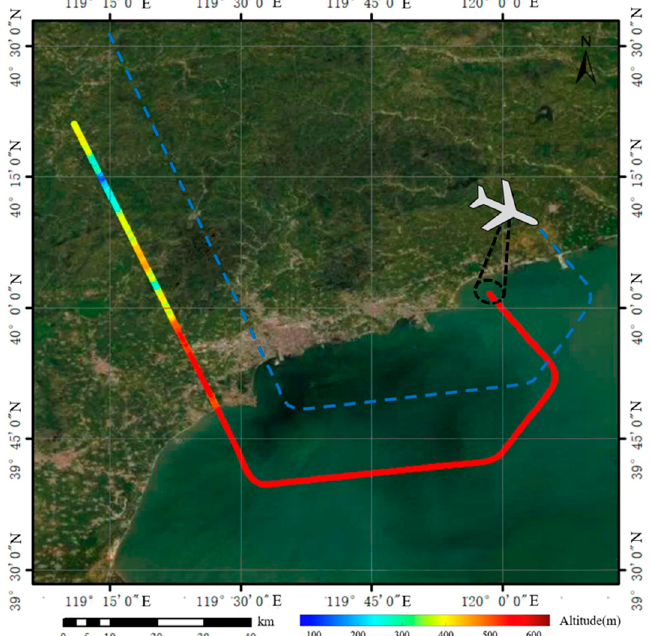
Figure 1. The experimental site and track of the flight on 14 March 2019 . The blue line represents the flight trajectory, with an average altitude of about 6800 m. The elevations of the ground footprints are indicated with different colors.